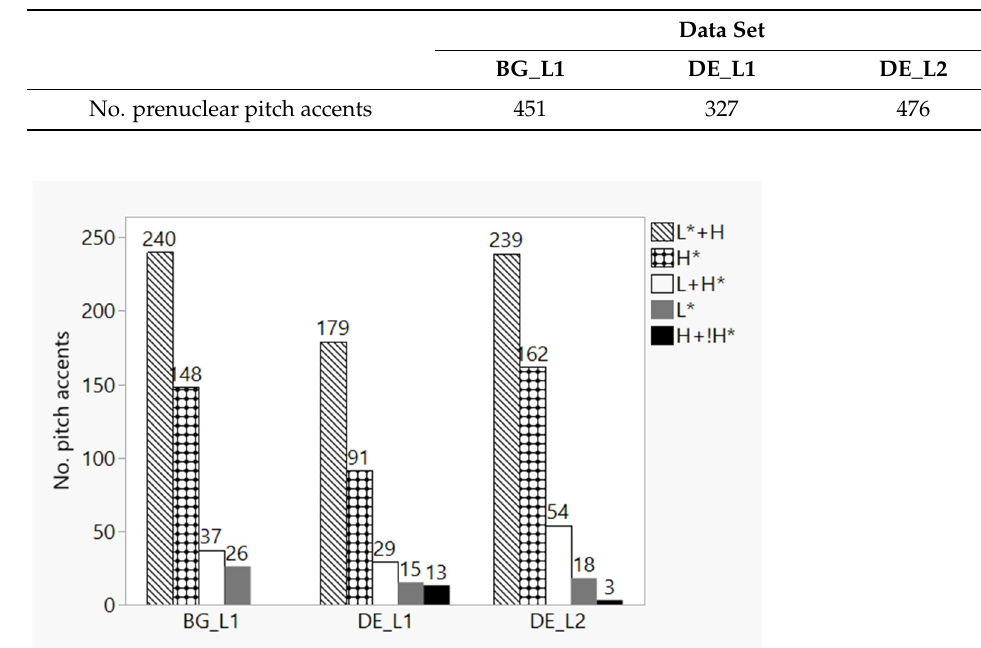
Table 2. Number of prenuclear pitch accents in the three data sets.